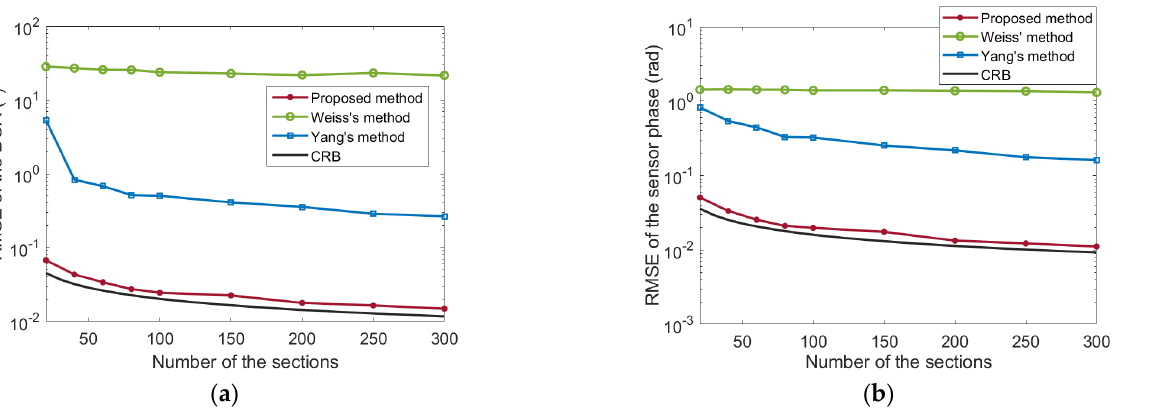
Figure 5. RMSEs versus the number of sections: ( a ) DOA estimation; ( b ) DD sensor phase estima- tion.